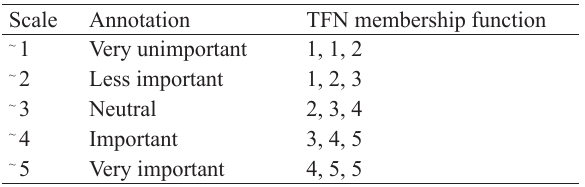
Table 4 Scale of weighting comparison among criteria of fuzzy-Eckenrode